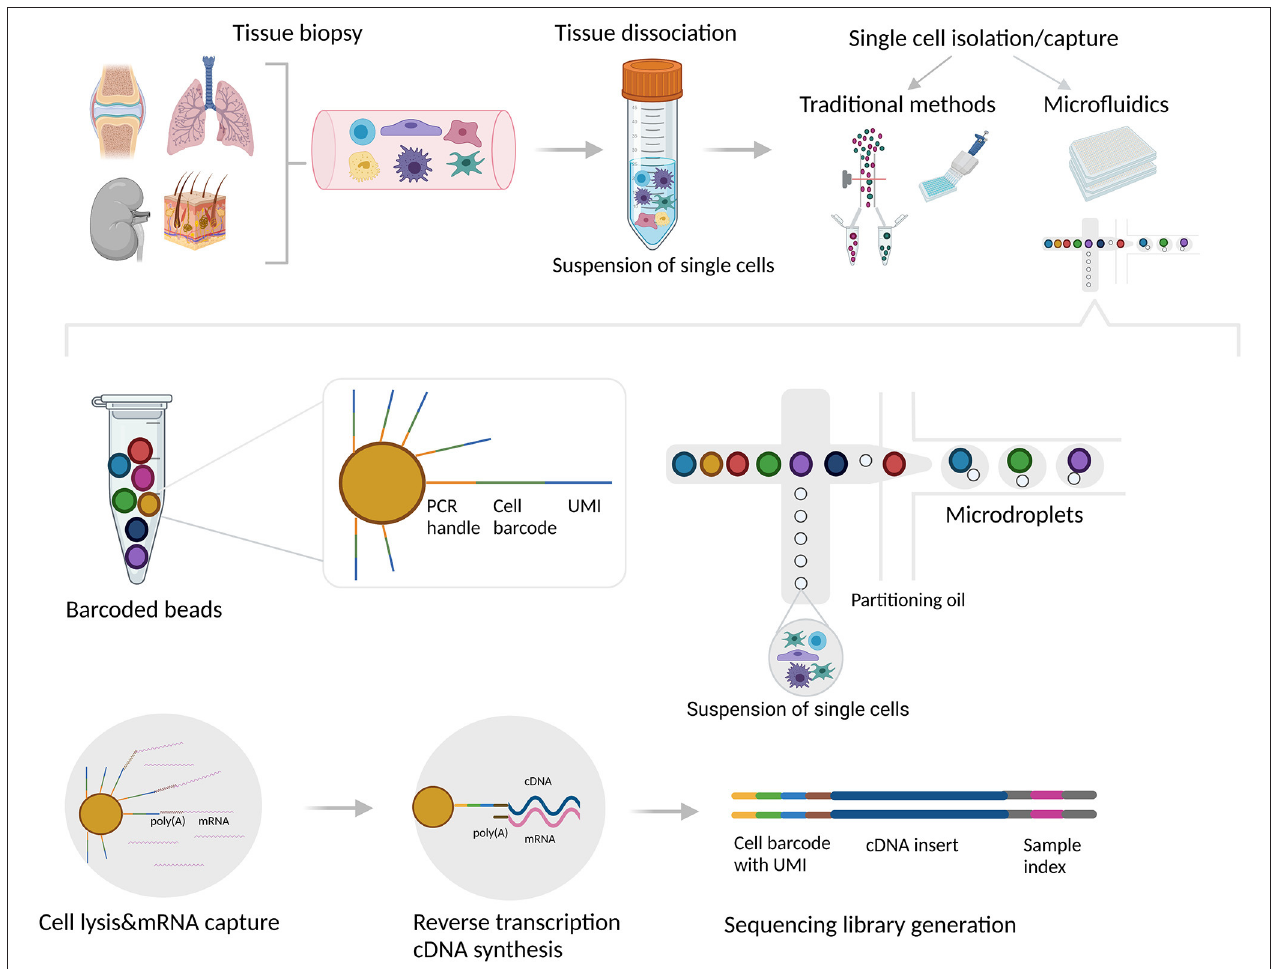
FIGURE 1 | Single cell isolation, capture and library generation using droplet-based microfluidic system. Tissue biopsies are usually dissociated mechanically and/or enzymatically. Single cells can be subsequently isolated and captured into individual reaction units using various methods/platforms. The traditional methods include limiting dilution, micromanipulation, laser capture microdissection (LCM), and flow-activated cell sorting (FACS). Although these methods can be used to separate individual cells into compartments, the downstream analytical processes (cell lysis, reverse transcription, and library construction) cannot be performed directly in these compartments. In contrast, microdroplet technology can be used for both: to capture each individual cell into one compartment/reaction unit, as well as to perform downstream reactions directly in every unit. In the droplet-based microfluidic system (i.e., 10x Genomics Chromium), aqueous droplets are formed in a continuous oil phase. Each droplet contains individual cell mixed with gel beads containing oligo sequences for a bead-specific barcode, unique molecular identifier (UMI) and poly-dT sequence which hybridizes with poly(A) tails of each mRNA. With reverse transcription, the bead-specific barcode integrates into the cDNA, allowing subsequent identification of the cell origin. The figure was created with